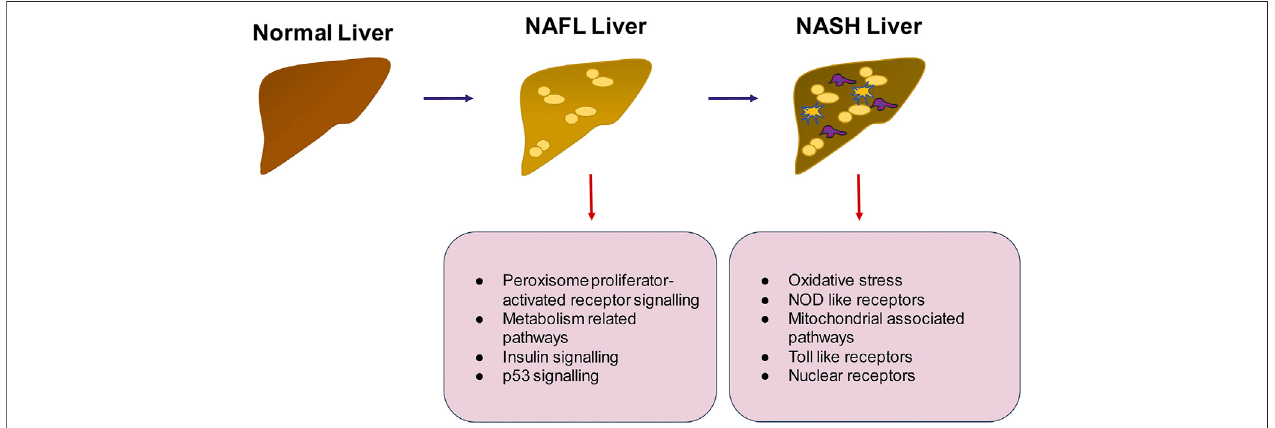
FIGURE 5 | Summary of pathways that may be important in the progression of NAFLD to NASH. The transition from healthy to NAFLD involves the activation of peroxisome proliferator activated receptor signaling, insulin signaling and p53 signaling whereas the switch to NASH involves activation of in fl ammatory pathways such as TLR and NOD like receptor mediated signaling, generation of intracellular oxidative stress and mitochondrial